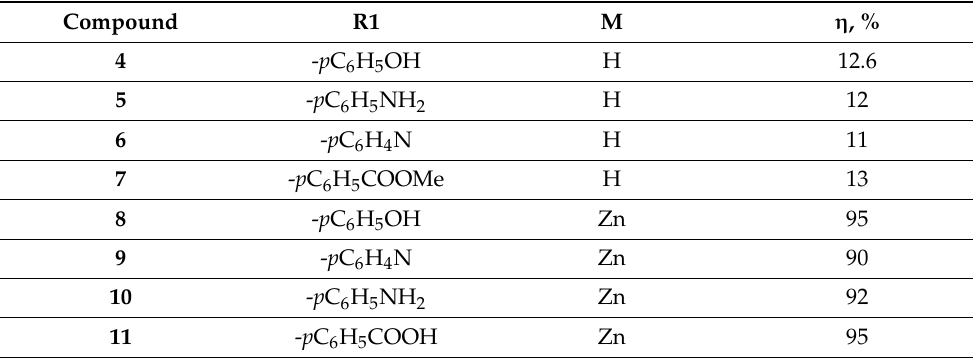
Table 1. The yield of asymmetric meso -arylporphyrins of A3B type. Compound